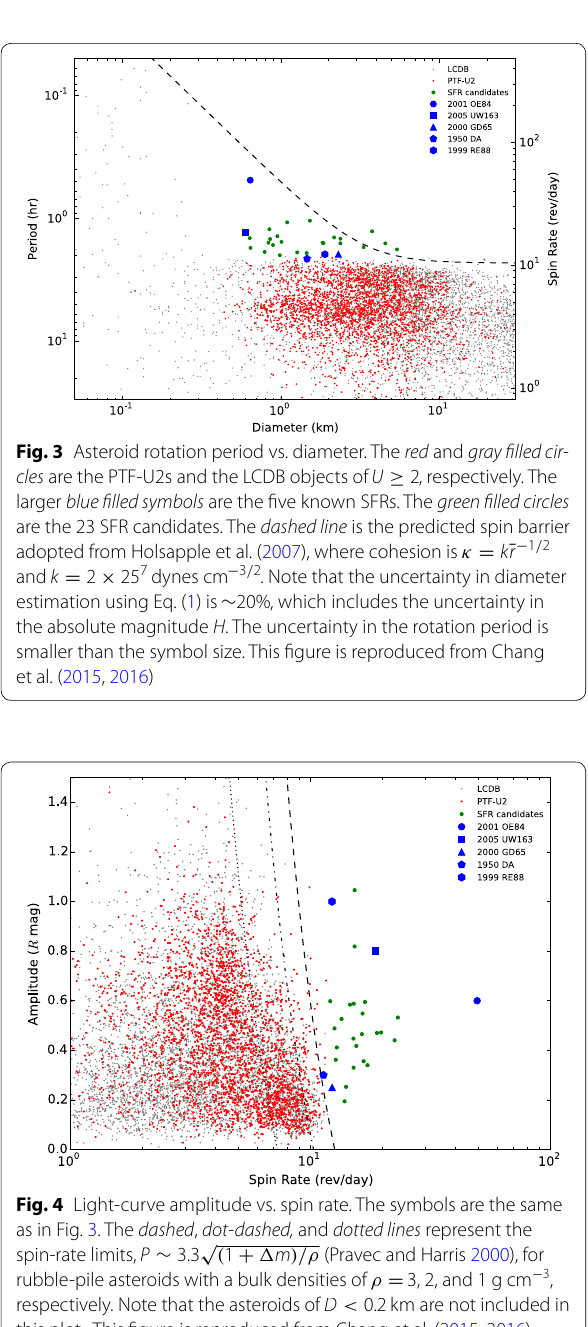
635 C-type asteroids and 1227 S-type asteroids. 6 The left column in Fig. 5 shows plots of light-curve amplitudes vs. spin rates for the C- and S-type asteroids (upper and lower panels, respectively). The C-type asteroids appear to have a boundary around the spin-rate limit for ρ